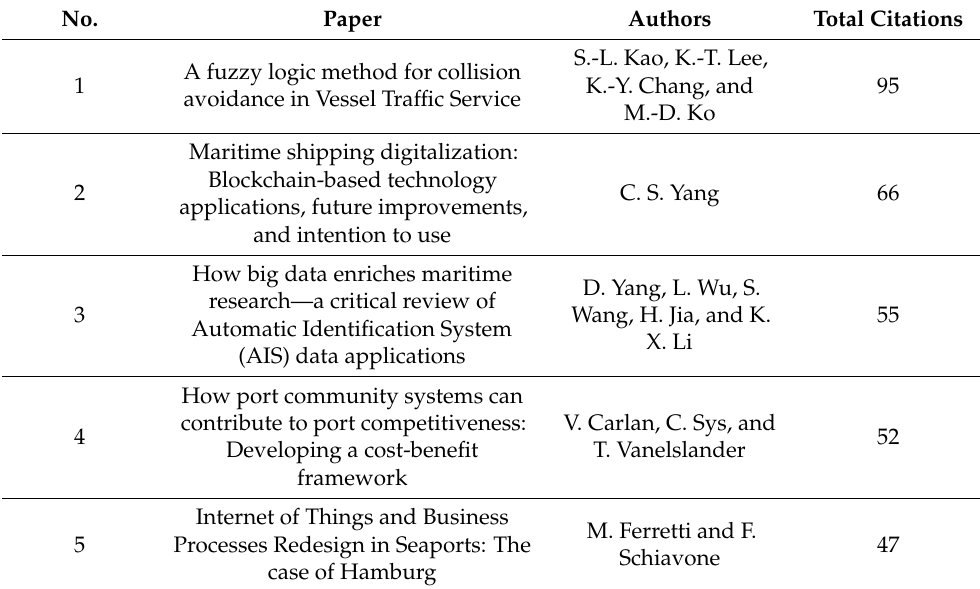
Figure 4. Distribution of the articles by their classification.